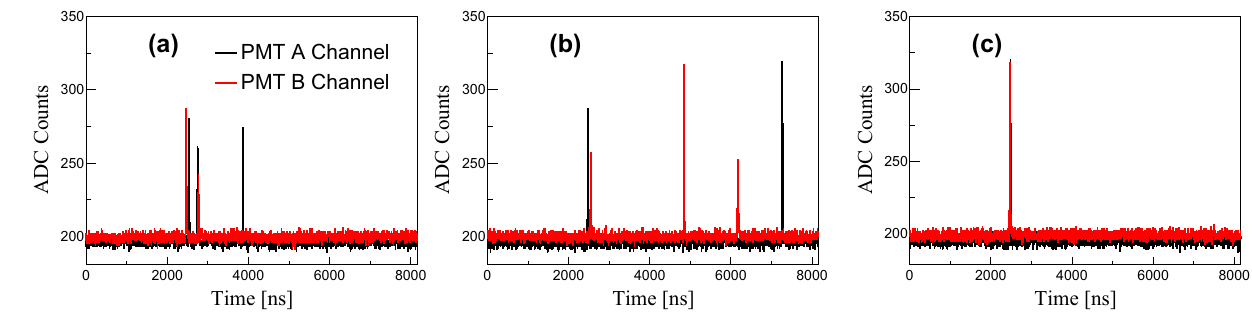
Fig. 20 a Example of the scintillation pulse with five photoelectrons. b Example of the software trigger rejected event with five photoelectrons. c Example of dominant (> 80% ) hardware triggered events, which have single use in each PMT, that are rejected by the software trigger